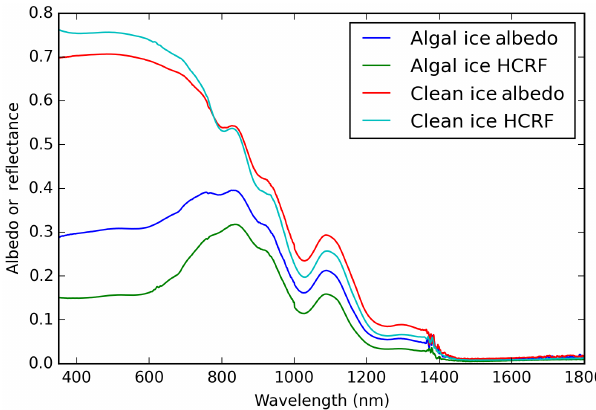
Figure 6. Field measured albedo (cosine collector) and nadir-view HCRF (8 ◦ collimating lens) for one clean ice and one algal ice sur- face. The spectra were collected using an ASD FieldSpec Pro 3 spectral radiometer following the methods described in Fig. 5 and Sect. 4.10 on 14 July 2017 during constant clear-sky conditions near the IMAU automatic weather station S6 on the Greenland Ice Sheet.